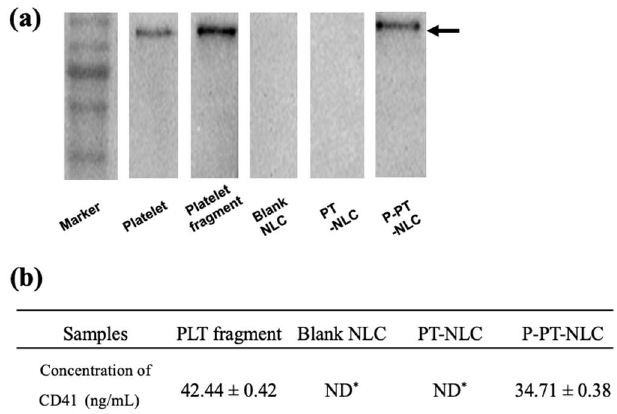
Figure 5. Identification of integrin α IIb (CD41) on P-PT-NLC. ( a ), western blot analysis; ( b ), enzyme- linked immunosorbent assay (ELISA) analysis ( n = 3, mean ± SD). ND*, not detected. Black arrow indicates the CD41 band (131 kDa).